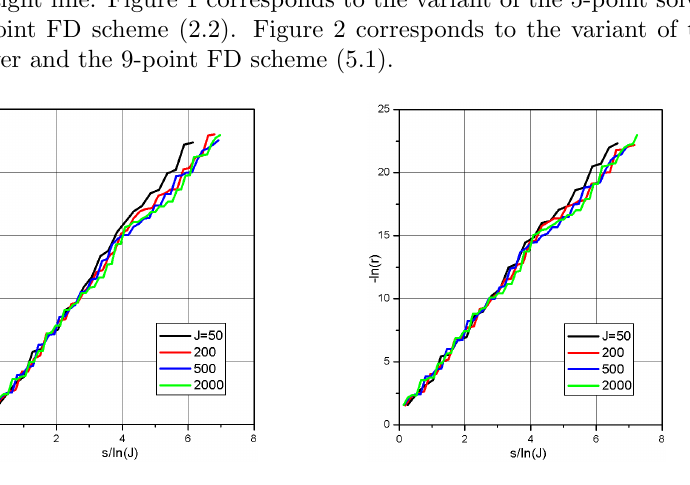
Table 2. Number of iterations on J . Dirichlet problem. In IFI, the 5-point solver, 5-point scheme is applied.